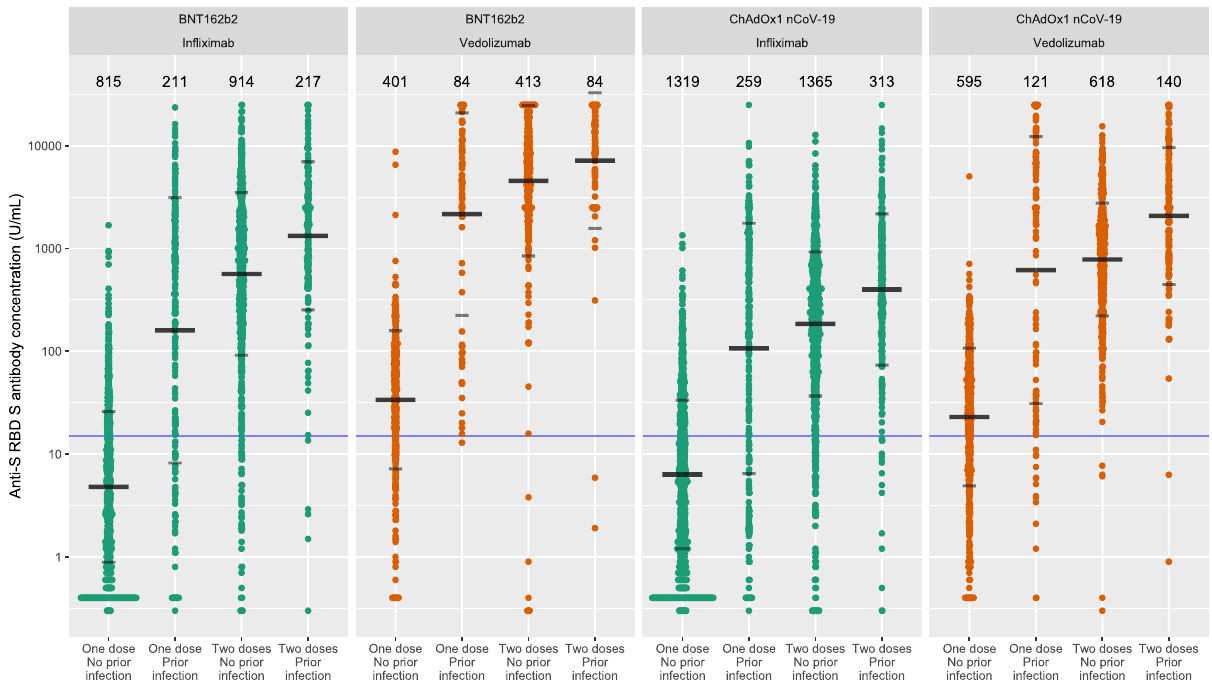
Fig. 1 Anti-S RBD antibody concentration strati fi ed by biologic therapy (in fl iximab vs vedolizumab), type of vaccine, vaccine dose and history of prior SARS-CoV-2 infection. The wider bar represents the geometric mean, while the narrower bars are drawn one geometric standard deviation on either side of the geometric mean. Based on published data using neutralisation assays threshold shown of 15 U/mL was used to determine seroconversion 11 . The biologic treatment in fl iximab is shown in green and vedolizumab in orange. The number of individuals tested for each group are shown in black at the top of each panel. Source data are provided as a Source Data fi